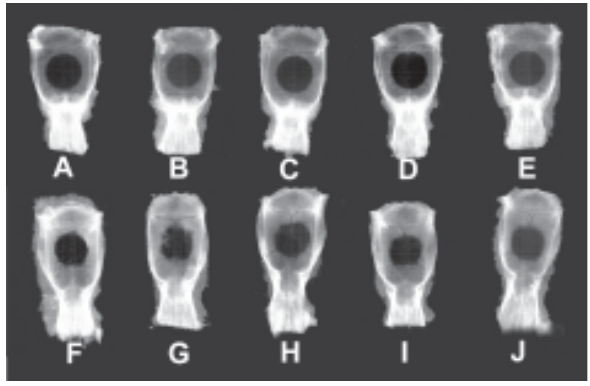
FIGURE 3.- Radiographic images of 0-hour ( A-E ) and 6- month ( F-J ) control groups